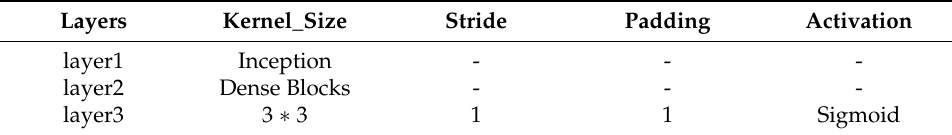
Figure 4. The Decoder Architecture of Network. Table 2. The Decoder Architecture of